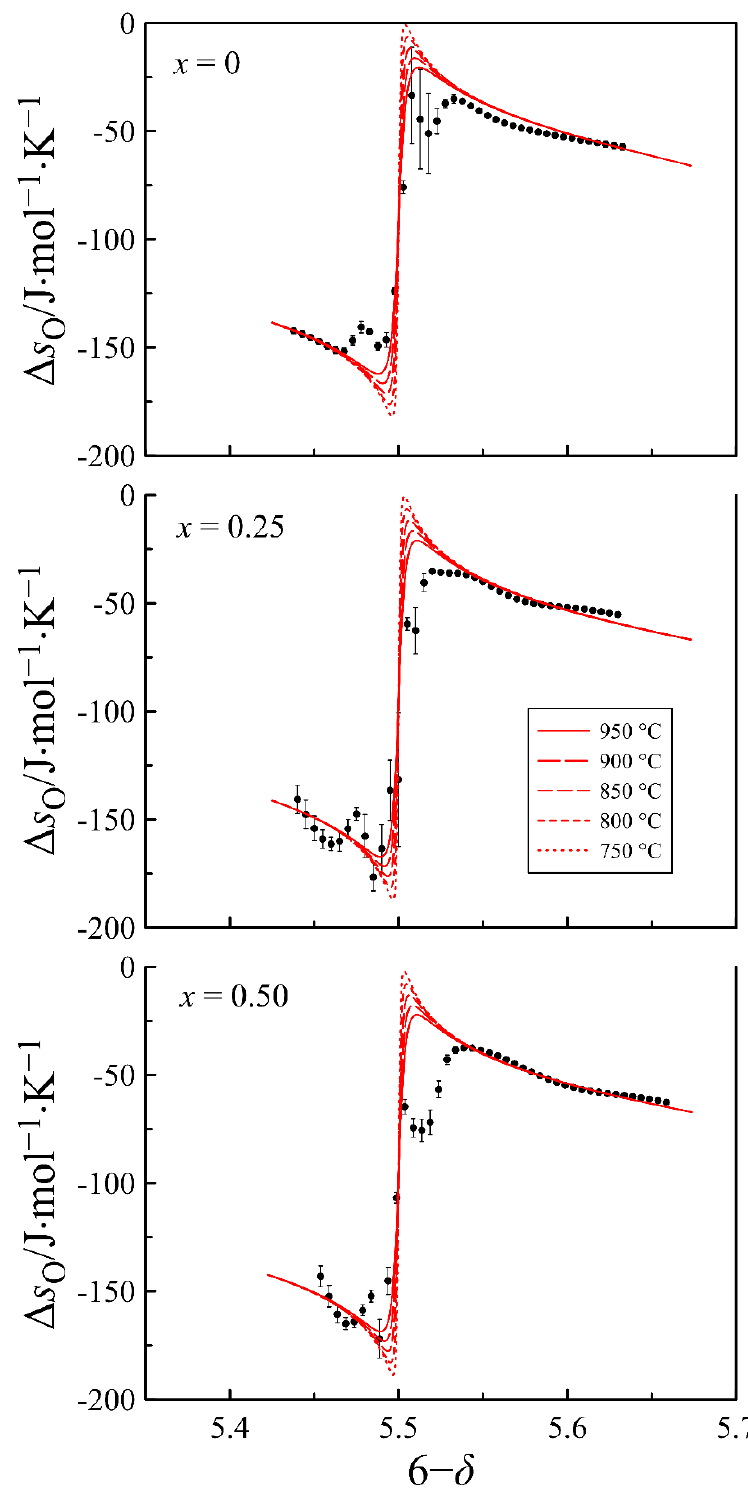
Figure 9. Partial molar enthalpy entropy of oxygen in PrBa 1 − x Sr x Fe 2 O 6 − δ as a function of oxygen content in the oxide. Dots show the results obtained using the Gibbs – Helmholtz relation (17). Lines represent the results of statistical thermodynamic calculations with Equation (24).